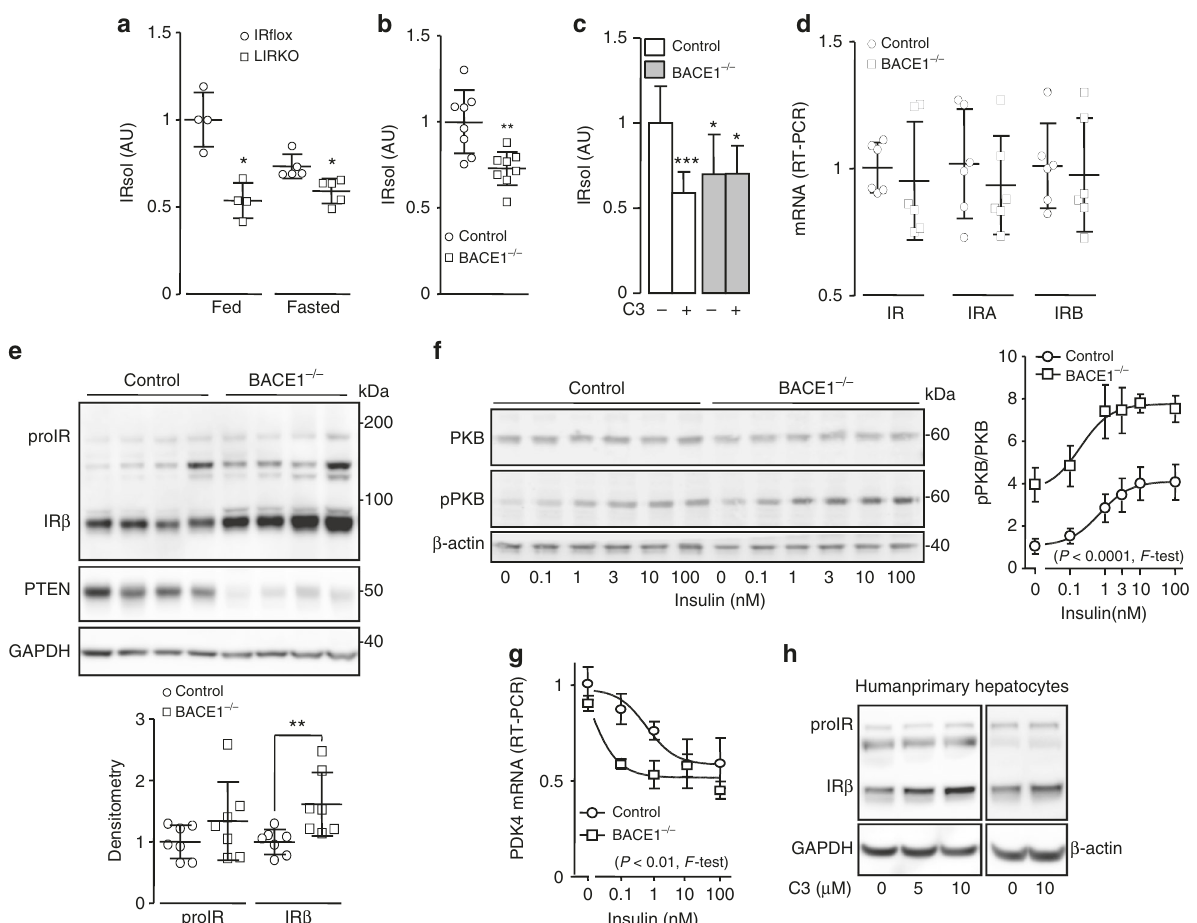
Fig. 6 In vivo cleavage of IR by BACE1. IRsol was measured in the plasma from a liver-speci fi c IR knockout mice (LIRKO; fed n = 4; fasted n = 5)and their fl oxed control (IR fl ox; fed n = 4; fasted n = 5), b BACE1 − / − mice ( n = 8) and their control littermates ( n = 8). c IRsol was measured in the conditioned media from control and BACE1 − / − liver explants treated or not with the BACE1 inhibitor (C3). d Levels of IR, IRA, and IRB mRNA were measured by RT- PCR in control and BACE1 − / − livers. e Levels of IR, PTEN, and GAPDH (loading control) were analyzed by immunoblot in control and BACE1 − / − livers, a densitometric analysis of the proIR and IR β bands normalized to GAPDH was performed (below the blot), values are expressed as fold over the means of the wild-type mice. f Primary hepatocytes isolated form control ( n = 4) and BACE1 − / − ( n = 3) mice were stimulated for 10 min with the indicated concentration of insulin. A representative immunoblot of insulin-stimulated phosphorylation of PKB at Ser 473 is shown. The curves on the right of the immunoblot are the normalized means ± s.e.m of the immunoblots (both curves differed signi fi cantly, p < 0.0001, F -test). g mRNA levels of PDK4 were measured by RT-PCR in control and BACE1 − / − primary hepatocytes stimulated for 6 h with the indicated concentrations of insulin (both curves differed signi fi cantly, p < 0.01, F -test). h Human primary hepatocytes (two different preparations) were incubated for 40 h in the presence of the indicated concentrations of BACE1 inhibitor (C3), then IR and GAPDH or actin (taken as loading controls) were analyzed by immunoblot. Data are means ± s.d. Statistical analyses was made using Mann – Withney ( a ), unpaired t -test ( b , d , e ), ANOVA followed by Dunnett ’ s test ( c ) or F -test ( f , g ) * p < 0.05; ** p < 0.01; *** p <